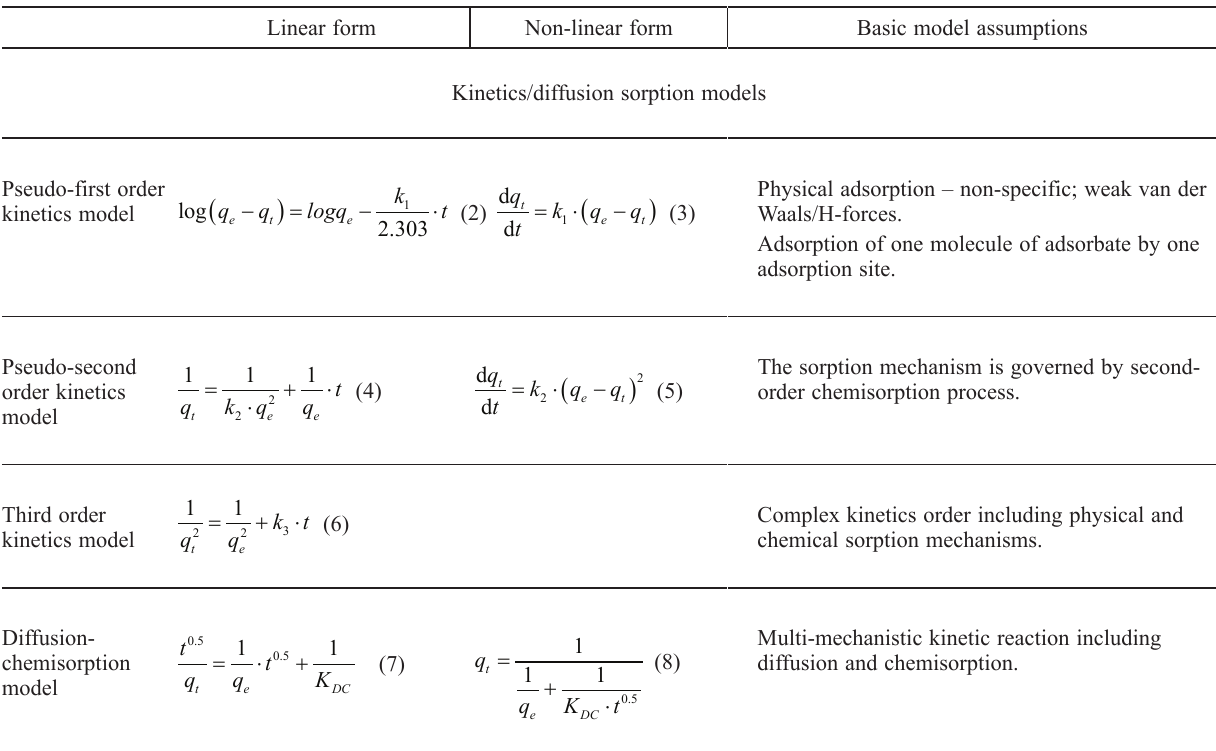
Table 2 – Linear and non-linear form of the kinetics, diffusion, and desorption models applied to the vitamin E/zeolite system Linear form Non-linear